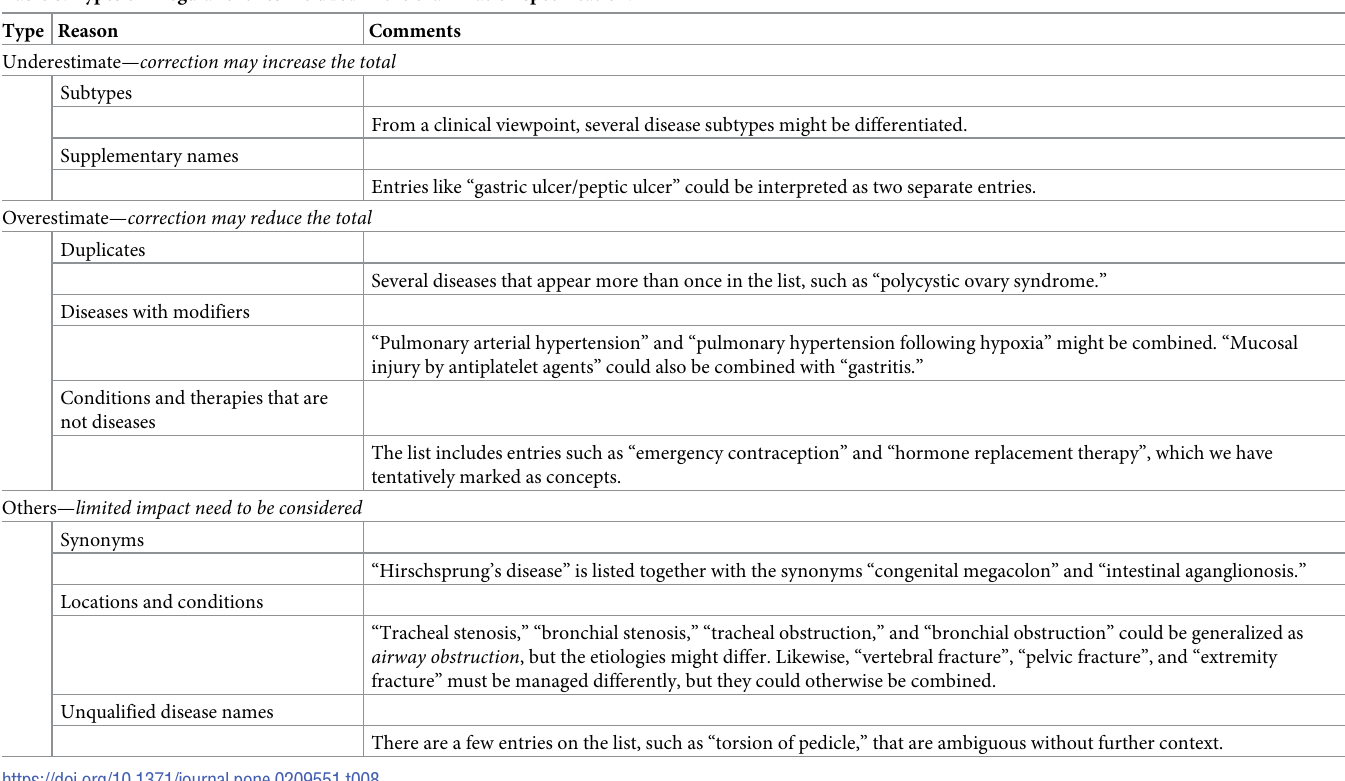
Table 8. Types of irregular entries included in the examination